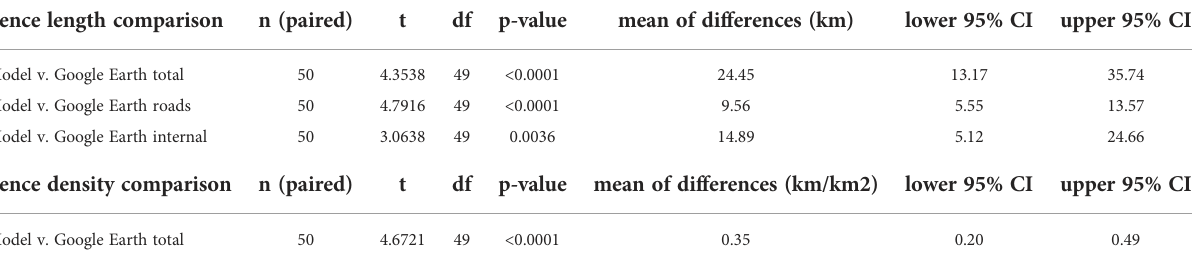
TABLE 2 Paired t-test results of comparing differences in the mean fence length (km) and mean fence density (km/km 2 ) modeled using GIS and mapped using Google Earth within non-forested areas of a random sample of 50 survey townships (mean non-forested area for each township was 76.1 km 2